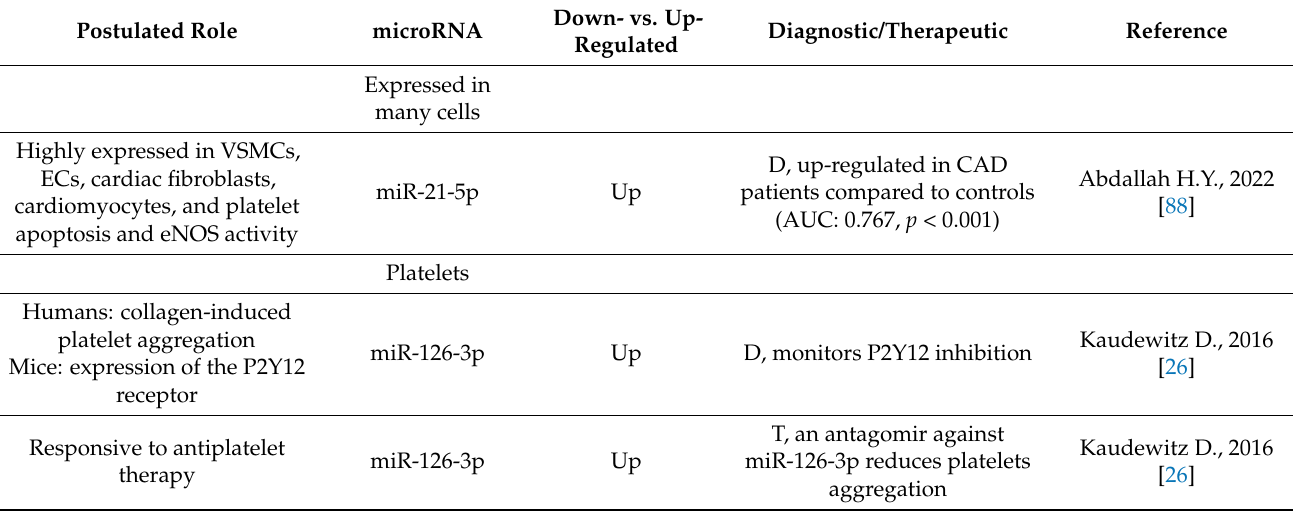
Table 1. Summary of the most clinically utile miRs in atherosclerotic coronary artery disease, with the inclusion of the miRs role, place of origin, expression levels, and